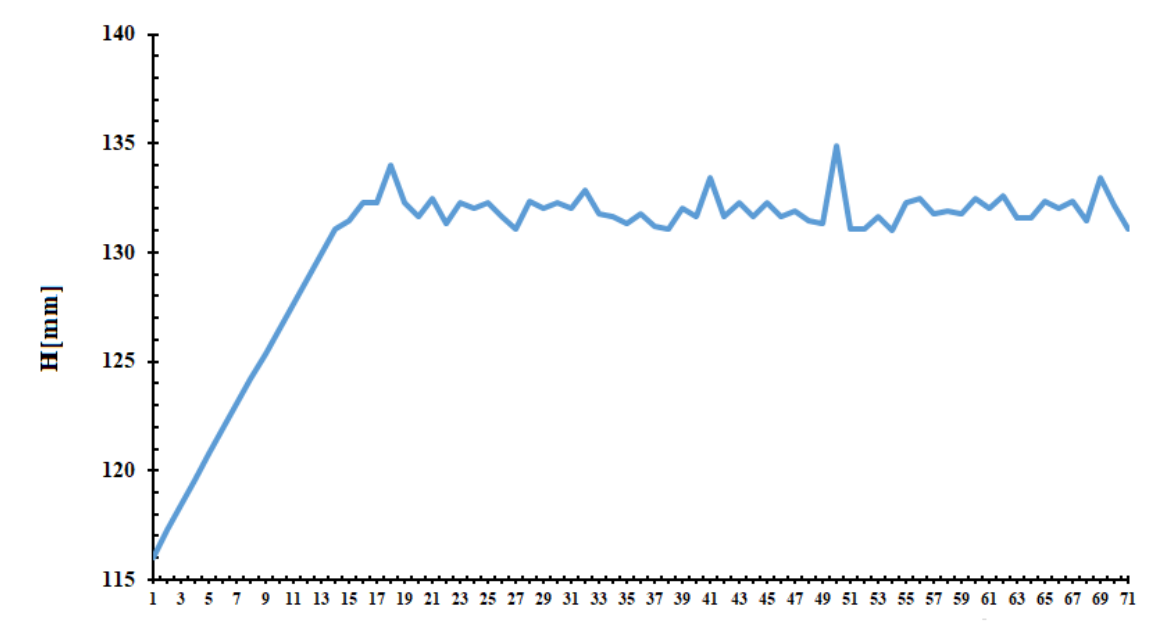
Figure 8. Evolution of the fluidized-sand bed height as a function of time, for a fluidization rate of 0.07 m.s − 1 . Numerical results obtained with a stack of initial height H 0 = 115 mm.